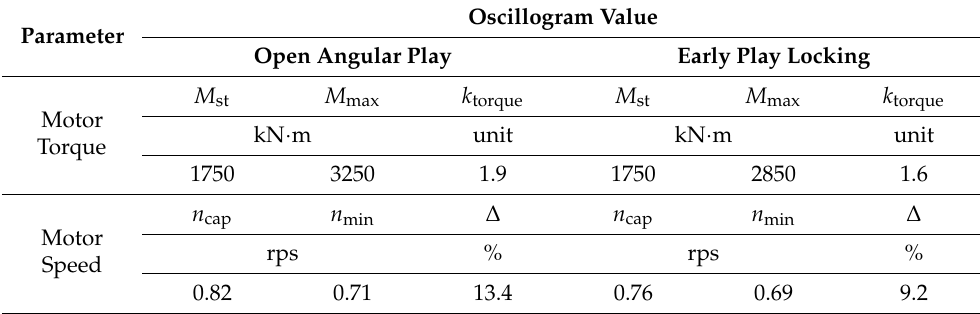
Table 2. Dynamic torque and speed deviations during